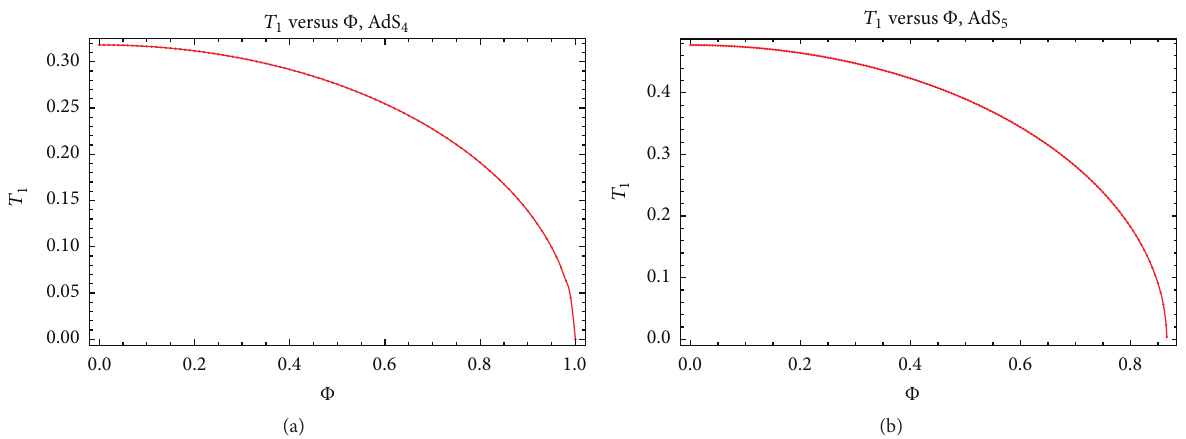
Figure 2: The phase transition temperature 𝑇 1 between the pure radiation and pBH for fixed Φ ensemble (dual to the fixed chemical potential